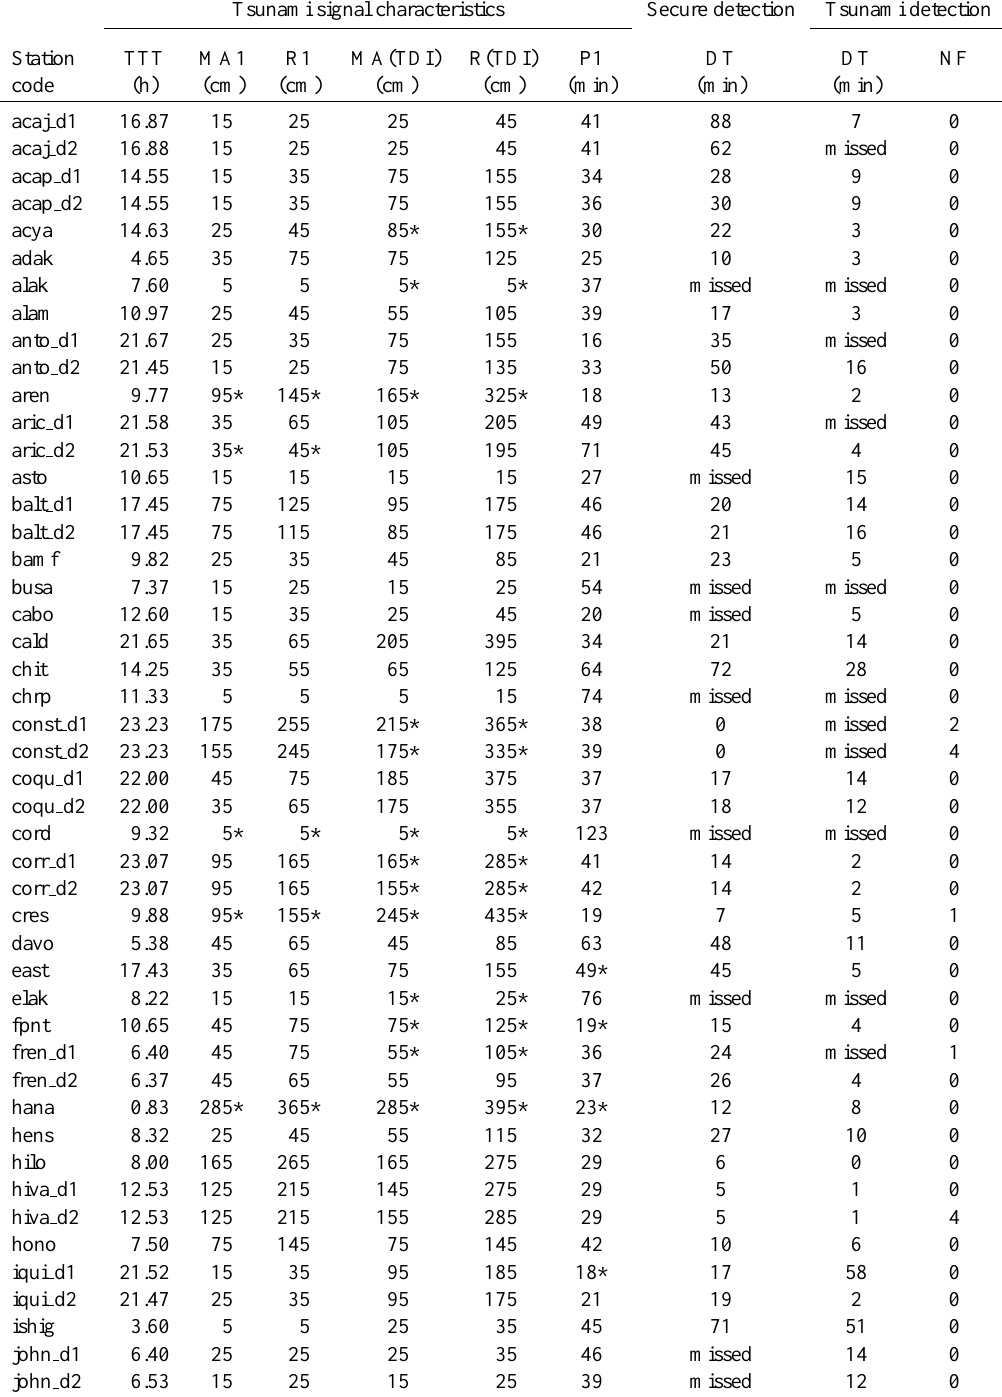
Table 2. Tsunami signal characteristics and results of TEDA detection: TTT, observed tsunami travel time; MA1, maximum amplitude (positive or negative) of the first wave; R1, range of the first wave; MA(TDI) maximum amplitude (positive or negative) in the tsunami detection interval; R(TDI) tsunami range in the TDI; P1, period of the first wave; DT delay time of the secure and tsunami detection; NF, the number of false detections of the tsunami detection module. An asterisk denotes that the value is uncertain owing either to missing data or to record saturation. The tsunami travel times refer to the original earthquake source indicated by USGS at 05:46 UTC. The results of TEDA secure detection and tsunami detection modules refer to parameters configuration C4. When the secure detection module makes a detection before the tsunami arrival DT is set equal to zero. This occurs only for the two records of Constitucion (const d1 and const